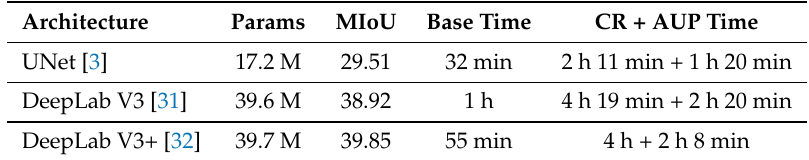
Table 5. The proposed method’s performance in terms of trainable parameters (time and space). We compared the performance of different methods using 100 labels on the ISAID